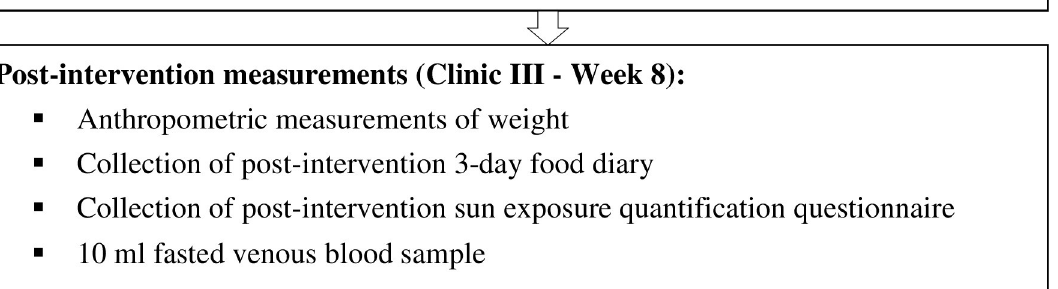
Fig 2. Study protocol